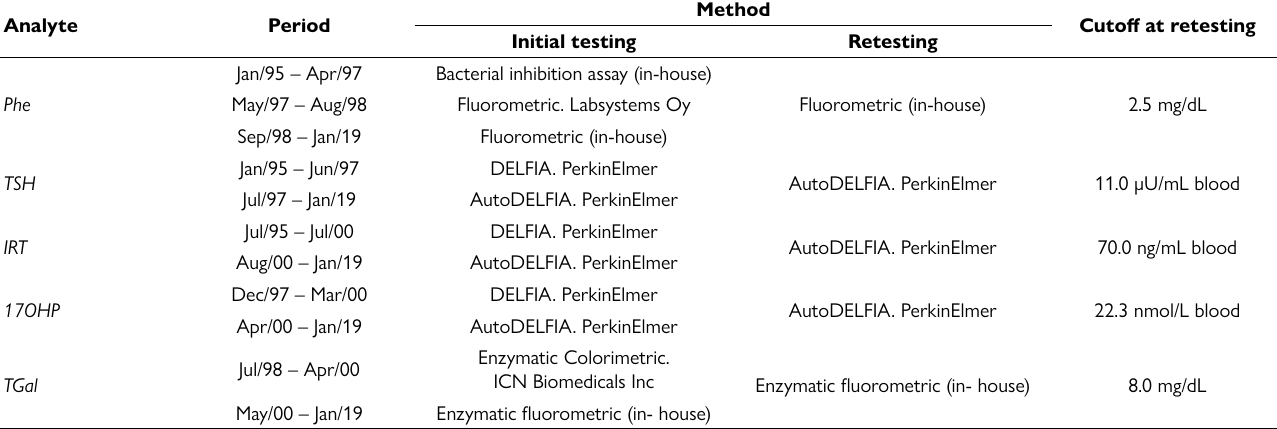
Table 1. Methods used for initial testing and retesting of DBS specimens included in the study.